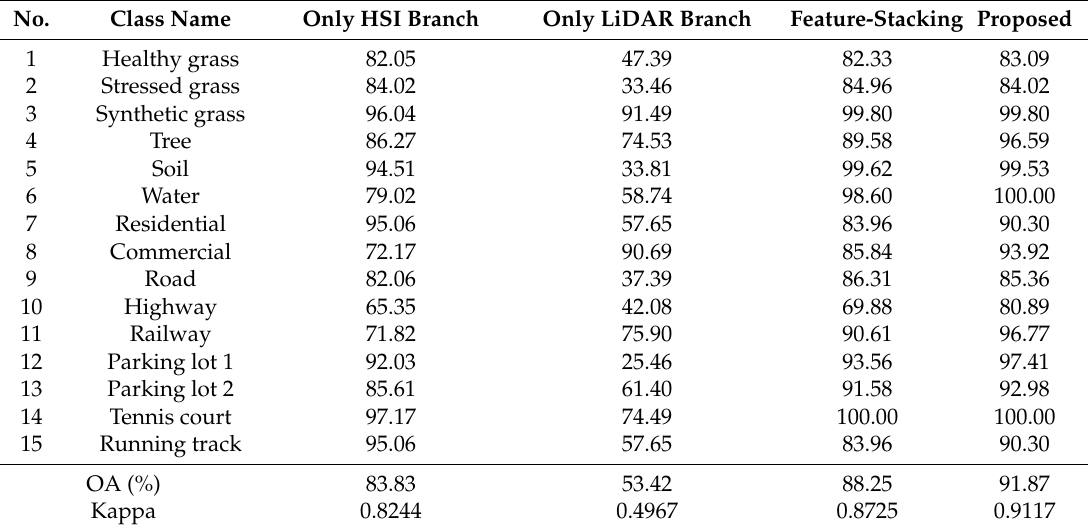
Table 5. Class-level classification